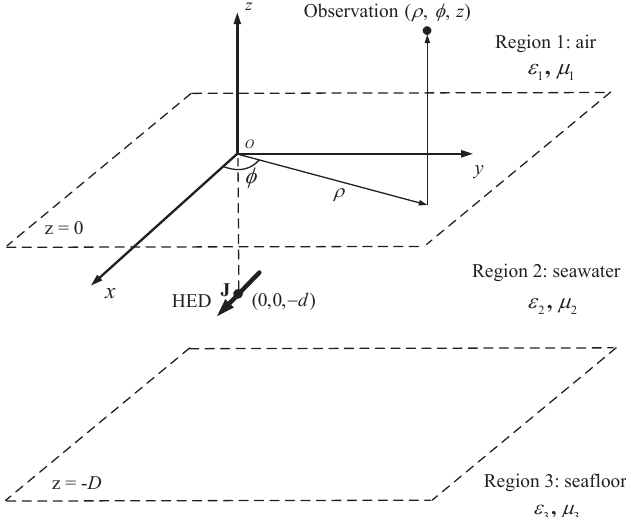
Figure 1. A horizontal electric dipole in three-layer